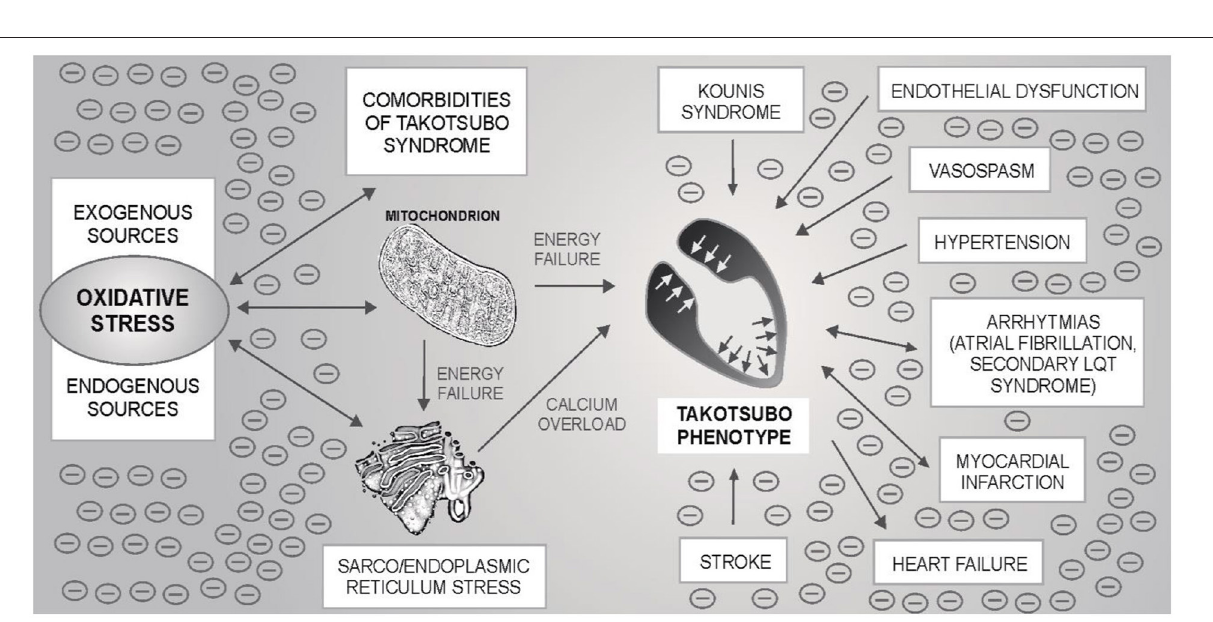
Frontiers in Cardiovascular Medicine |